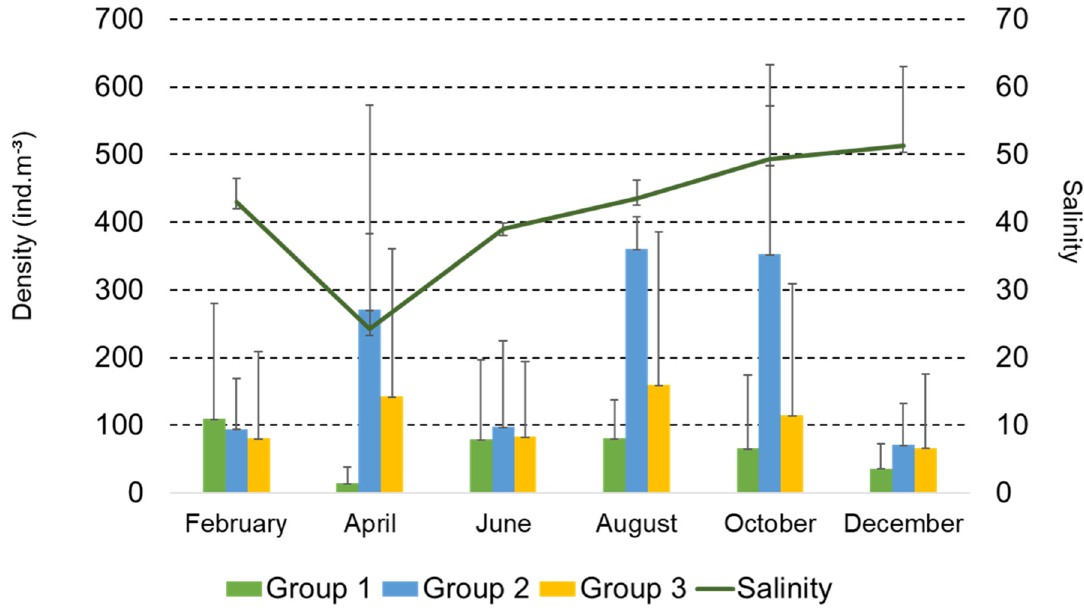
Figure 7. Identification of the functional groups of copepods in Piranji Estuary (equatorial Southwestern Atlantic, Brazil) during an intense drought period (year 2015). Groups 1 and 2: sac spawners. Group 3: broadcasters. Ca: Calanoida. Cy: Cyclopoida. H: Harpacticoida. The mean abundance of groups ranged from 14.6 ± 23.6 ind.m − 3 (Group 1—April) to